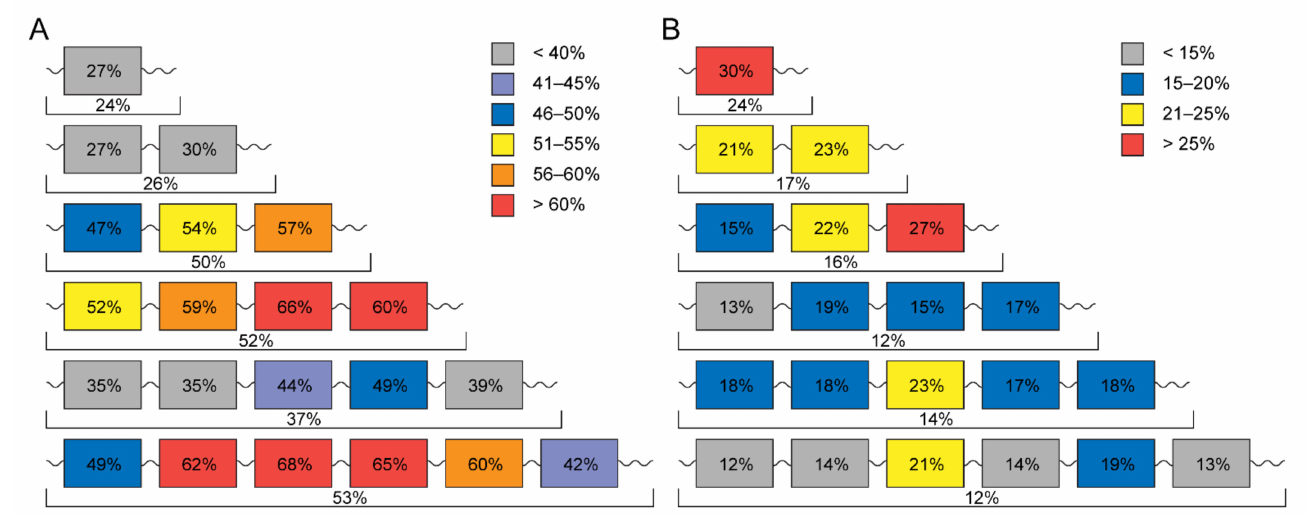
Figure 2. Average percentage of identity ( A ) and amyloidogenic regions predicted by the FoldAmy- loid program [37] ( B ) within each domain as well as all domains in proteins containing different numbers of domains are given. A dataset containing 1331 records of ribosomal S1 proteins was used